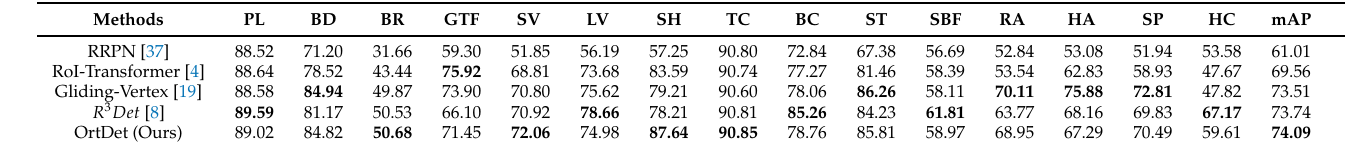
Table 1. Mean average precision (%) of the different methods for the DOTA-v1.0 dataset. Methods